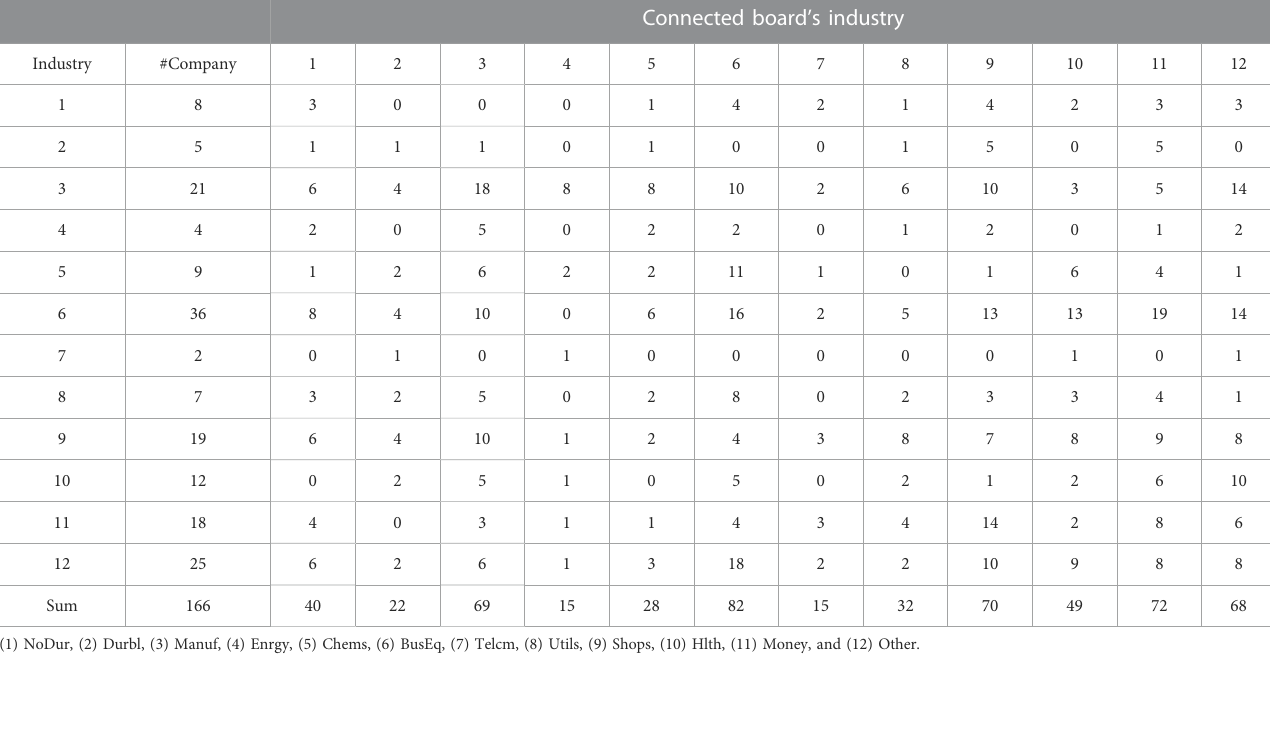
Connected board ’ s industry